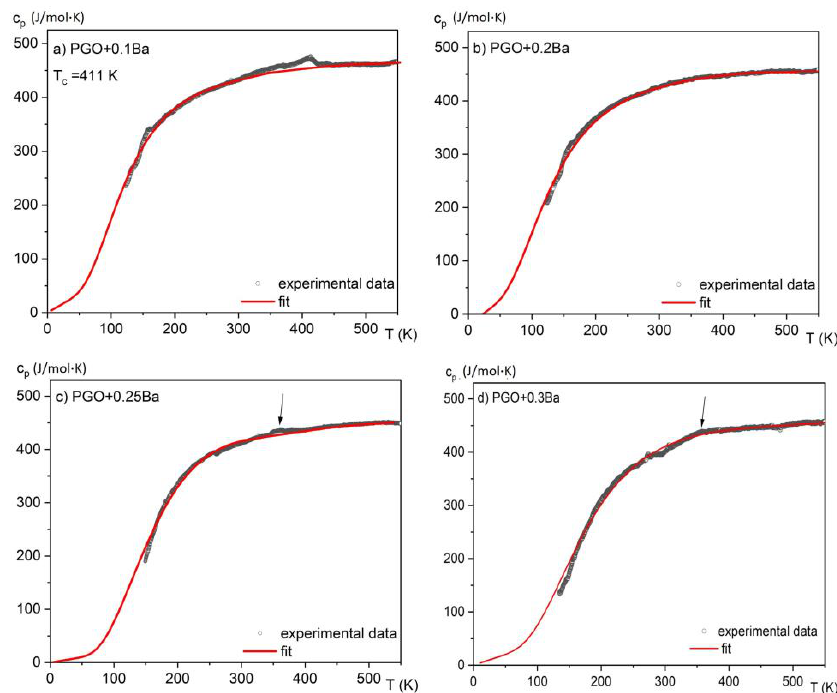
Figure 4. Temperature dependences of the specific heat for different compositions of PGO + xBa crystals: ( a ) PGO + 0.1Ba, ( b ) PGO + 0.2Ba, ( c ) PGO + 0.25Ba, ( d ) PGO + 0.3Ba. The arrows point to weak but visible anomalies connected to the phase transition for PGO + 0.25Ba and PGO +